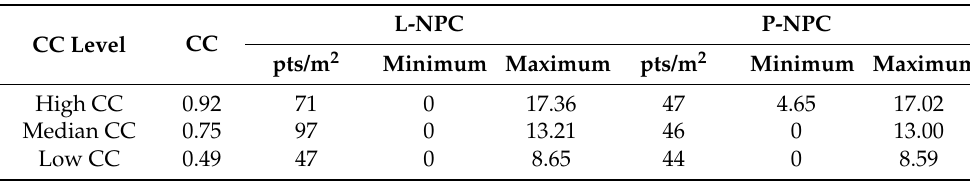
Table 4. The basic information of three plots with different CC.